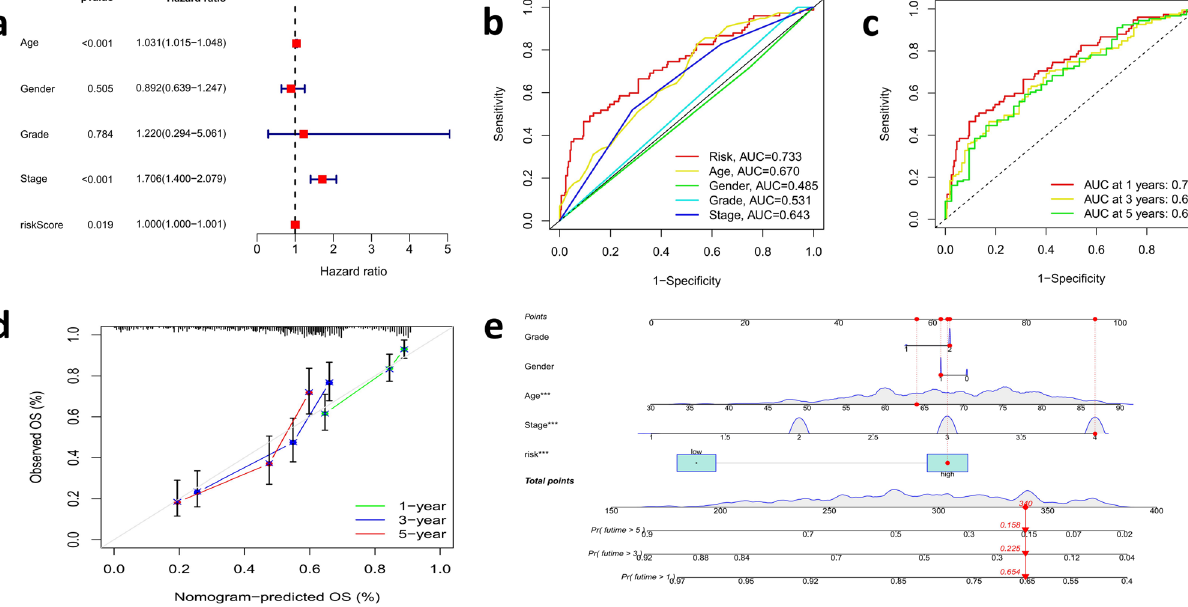
Fig. 6 Prognostic value of CRLs signature in TCGA–BCa cohort a Multivariate cox regression analysis for the risk score signature as an inde- pendent prognostic factor. b , c Predictive sensitivity and specificity of risk characteristics using ROC curves. d , e A nomogram and its calibra- tion were constructed to quantify the 1, 3, and 5 year survival probabilities by using independent predictors including tumor stage, age, gender and risk